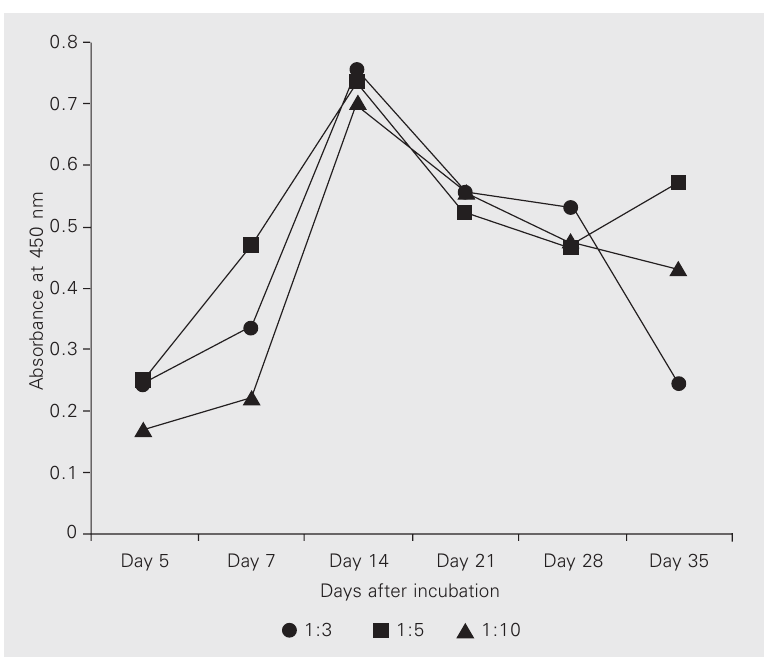
Figure 1. Assay of hepatitis A virus strain HAF-203. Eight wells were used for each dilution (1:3; 1:5; 1:10) for each day post-incubation. The initial dilutions are given in the inset. Data are reported as means of absorbance at 450 nm. SD was